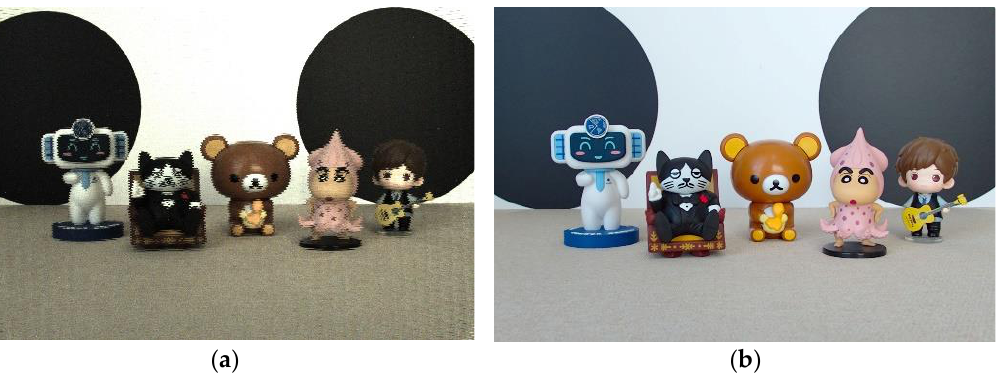
Figure 2. Scene 1 light field full-focus image. ( a ) The original images of the light field. ( b ) The full-focus images of the light field.